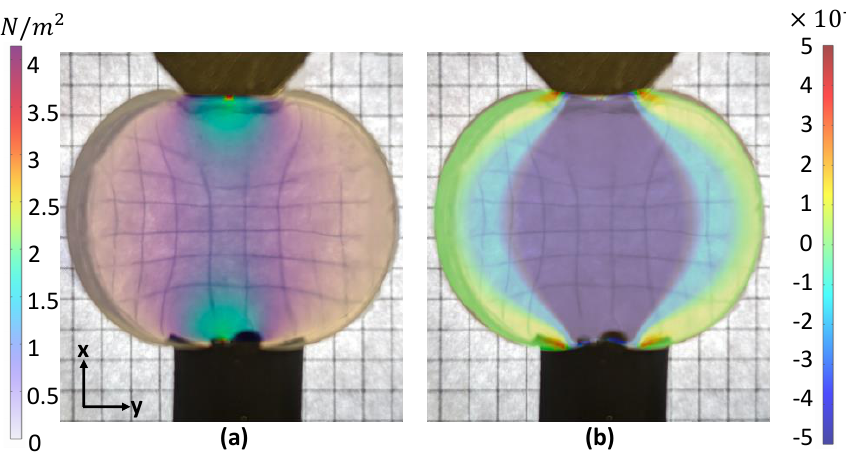
Figure 2. Semitransparent color − maps simulated in COMSOL Multiphysics ™ laid over the picture of silicone under pressure. ( a ) Von Misses Stress | σ | distribution map. ( b ) Color map distribution of the refractive index change n x − n y . The checkered pattern on the background used to highlight the deformation of silicone